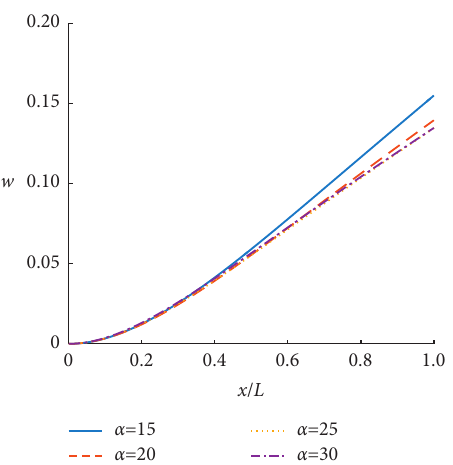
Figure 11: Influence of the parameter α on the deflection amplification factor at different locations of the beam.